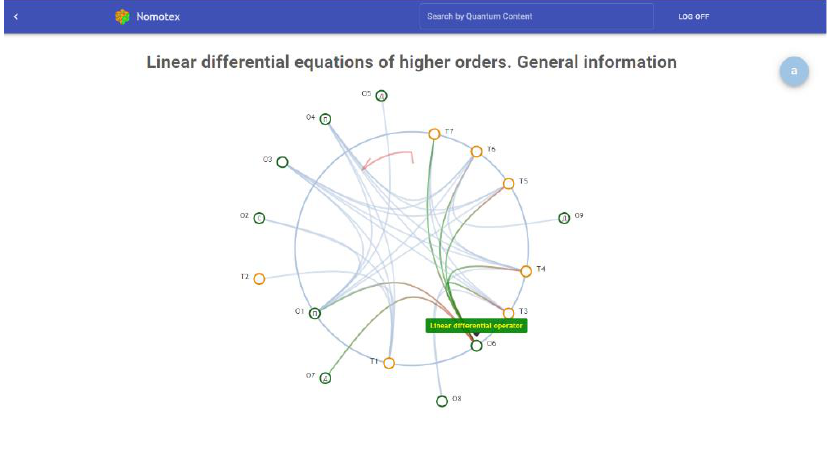
Fig. 2. Contents of the